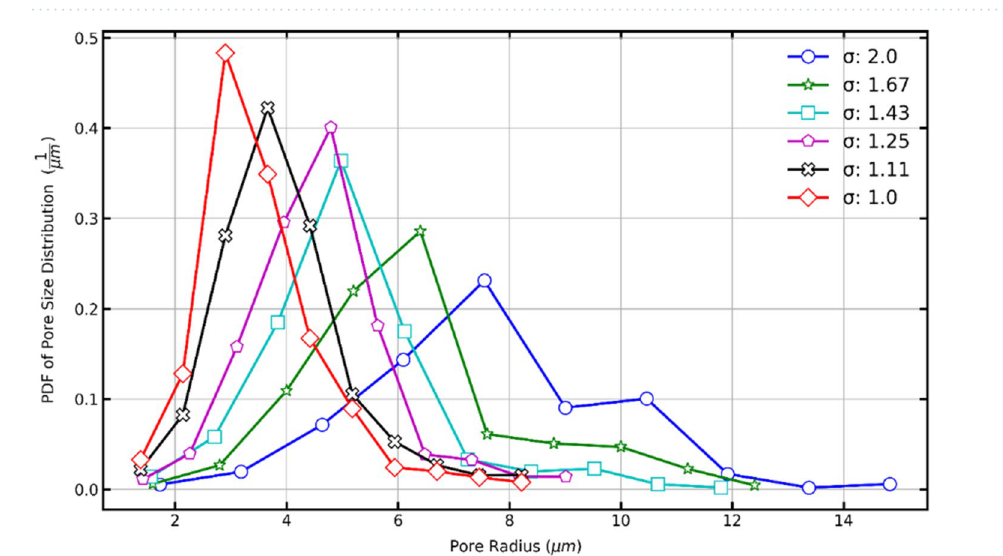
Figure 18. Probability density function (PDF) of pore size distribution of porous media with sigma